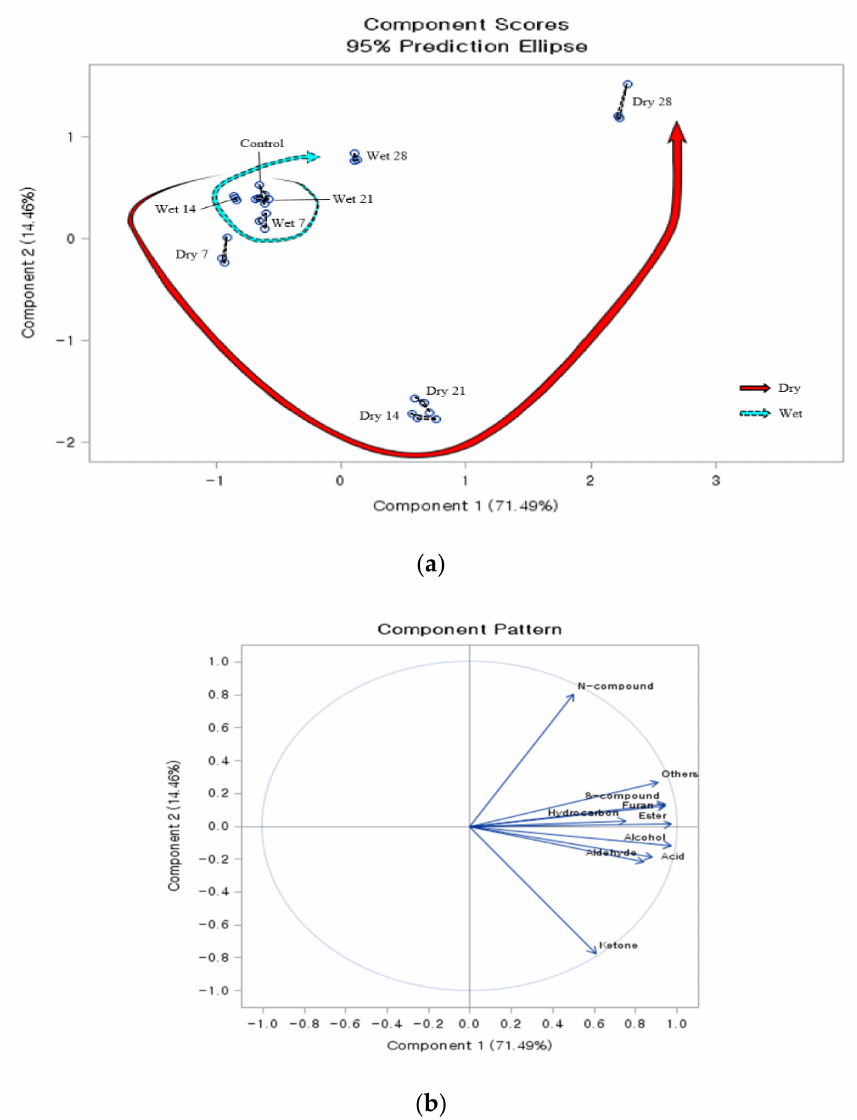
Figure 1. ( a ) Principal component analysis score plot; ( b ) the loading plot for the changes in patterns of aroma volatiles of beef during aging with different aging methods. Red solid-line arrow illustrates the change in aroma patterns in dry-aged beef, and blue dotted-line arrow indicates the change in aroma patterns in wet-aged beef during aging. Unaged beef (control), dry-aged beef (dry), wet-aged beef (wet), N-containing compound (N-compound), and S-containing compound